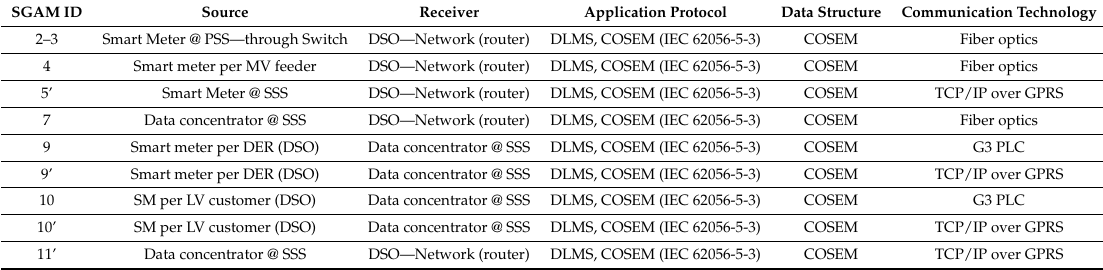
Table 7. Summary of potential critical links to be considered in the quantitative analysis for the Large Customer Commercial VPP